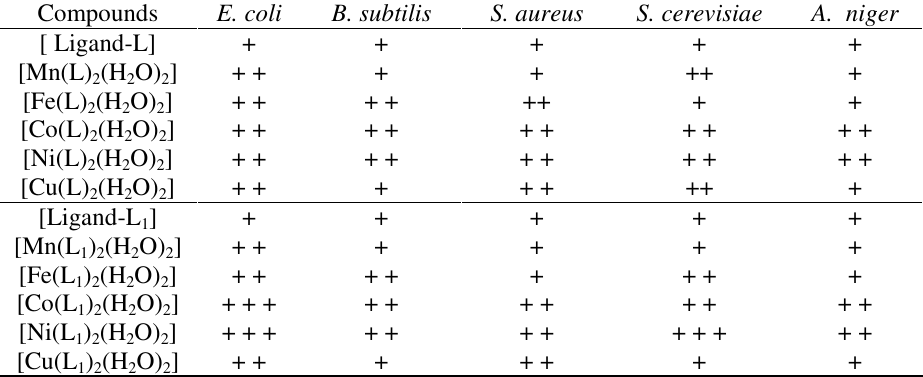
Table 3. Antibacterial activity of ligands and its metal complexes (control-DMF)